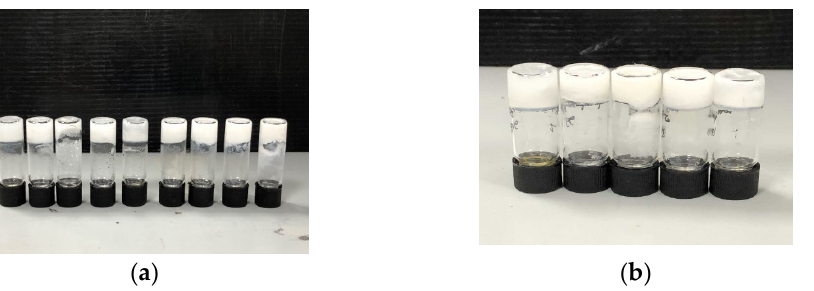
Figure 1. ( a ) Gels of G1 at 2% wt. in (from left to right) dichloromethane, ethanol, water, 1-pentanol, 1-propanol, 2-butanol, acetone, acetonitrile and ethyl acetate. ( b ) Gels of G1 at 1% wt. in (from left to right) dichloromethane, 1-pentanol, ethyl acetate, water and 1-propanol.